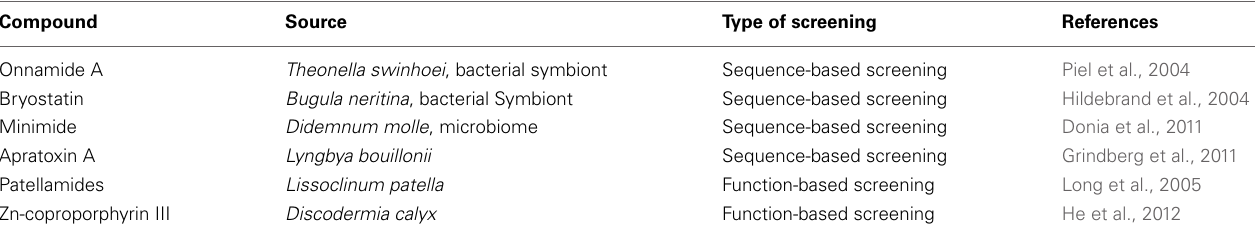
Table 2 | Natural products discovered through metagenomic